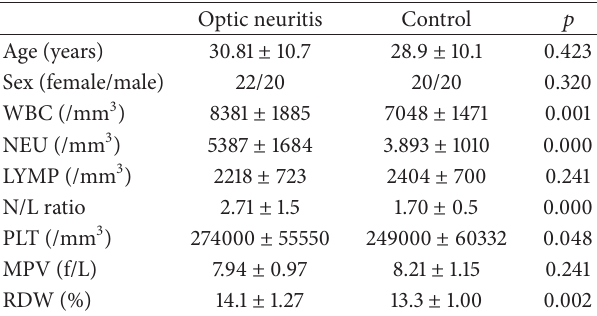
Table 1: Demographic characteristics and laboratory results of patients and control groups.